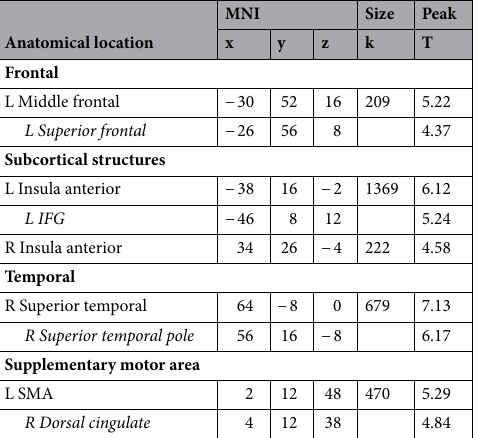
Table 1. Adults’ activation for the contrast words (positive, negative, neutral) compared to pseudowords (FWE corrected, p < 0.05, cluster level). x, y, z peak coordinates according to MNI stereotactic space, k cluster size in voxels, T -values for peaks, R right, L left, IFG inferior frontal gyrus, SMA Supplementary motor